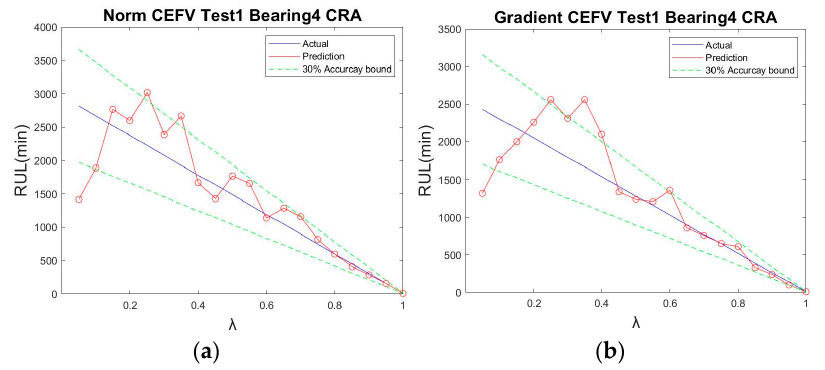
Figure 12. CRA of IMS Test 1 Bearing 4: ( a ) using the norm tracking value; ( b ) using the gradient tracking value.